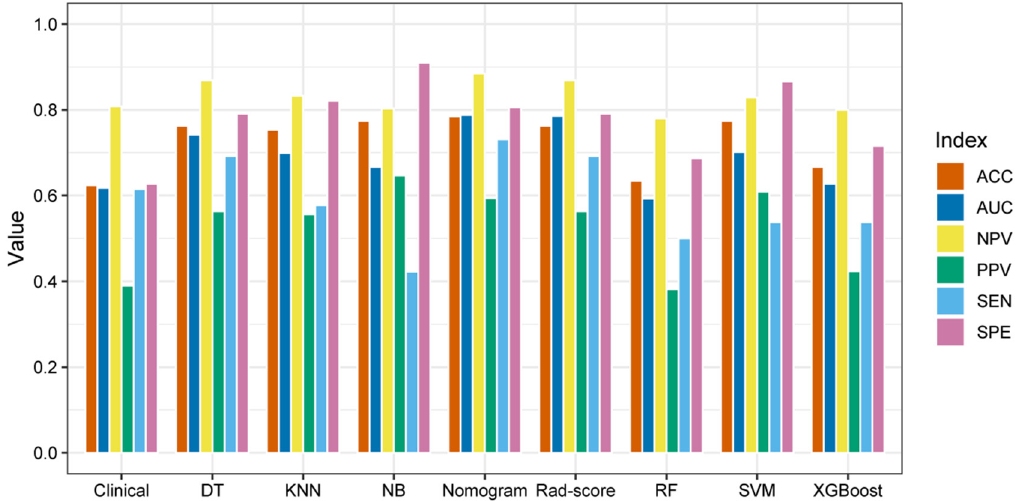
Figure 10. Bar plot of the performances of the nine prediction models in the validation set.